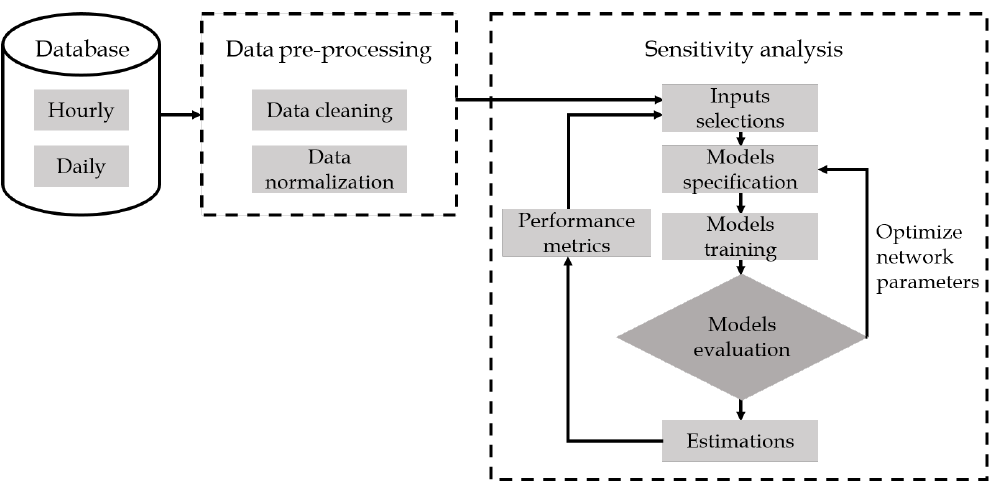
Figure 3. The block diagram of the proposed sensitivity analysis for estimating PN